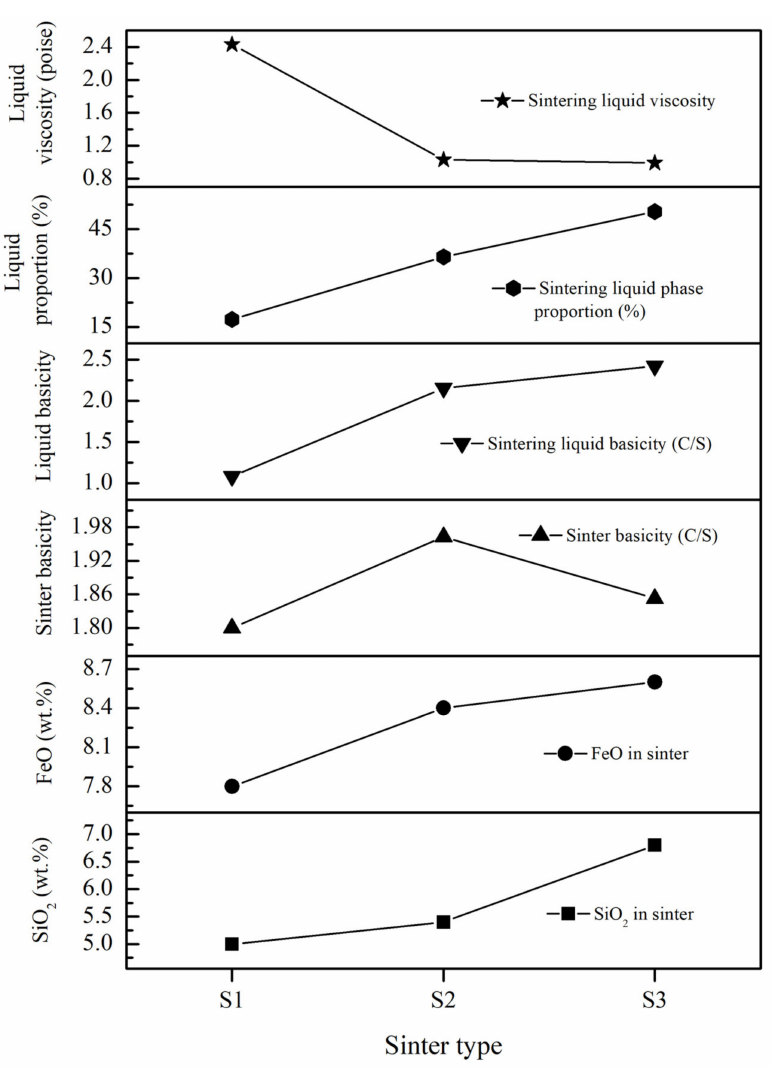
Figure 3. Sintering liquid properties of the three sinters upon reheating and quenching with respect to sinter bulk compositions.